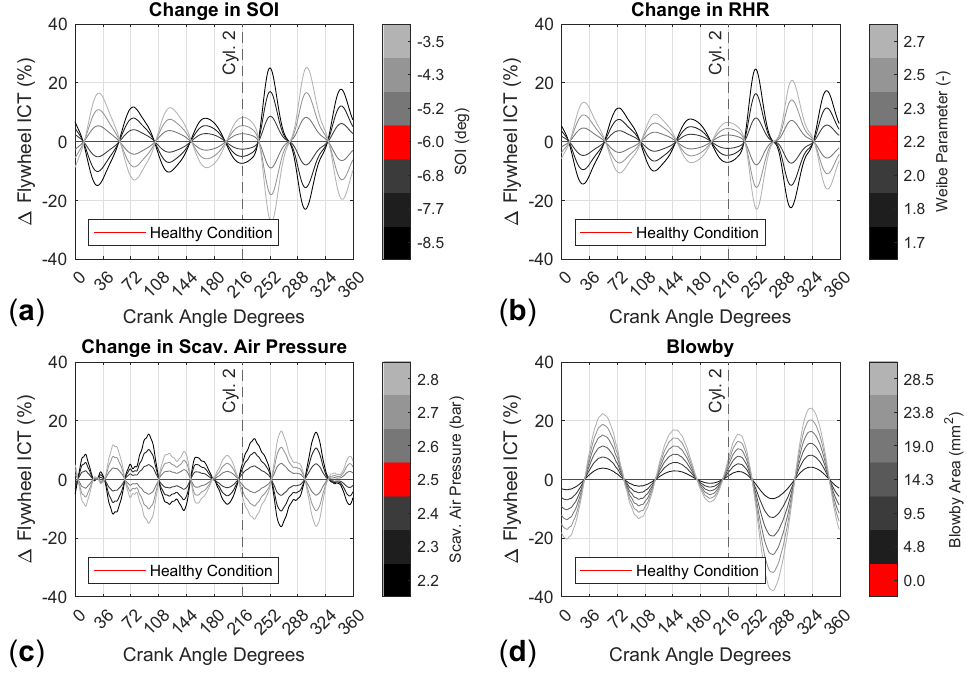
Figure 5. Normalised difference in flywheel ICT of the healthy engine conditions and the cylinder 2 malfunctioning conditions of ( a ) change in SOI, ( b ) change in RHR, ( c ) change in scavenge air pressure, and ( d )